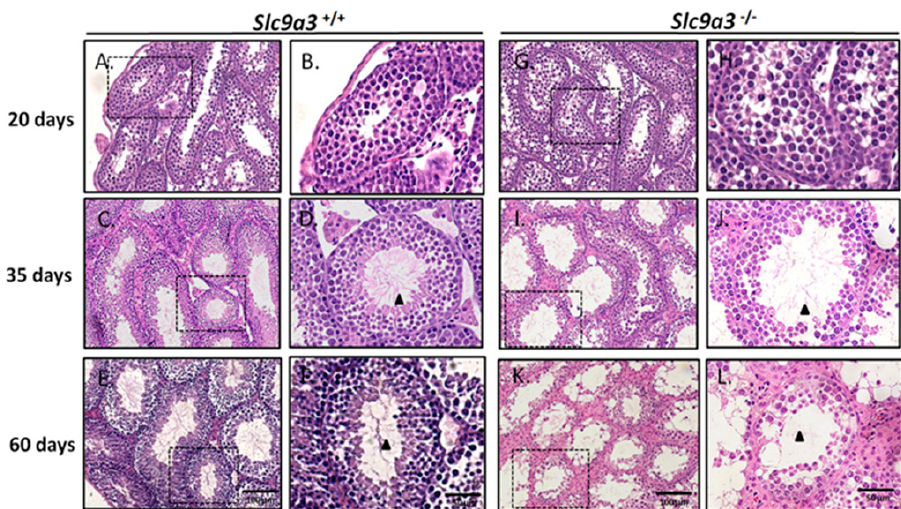
Figure 5. The testicular sections of 20-, 35-, and 60-day-old Slc9a3 knockout mice. Comparison of the testicular sections of WT ( A – F ) and Slc9a3 − / − ( G – L ) mice according to H&E staining; ( B , D , F , H , J , L ) enlarged images from the areas boxed by a black dashed box in ( A , C , E , G , I , K ); Scale bar = 100 μ m ( E , K ) and 50 μ m ( F , L ); Elongated spermatids ( arrowhead ) observed in the ducts of the seminiferous tubules ( D , F , J ) but absent in ( L ).